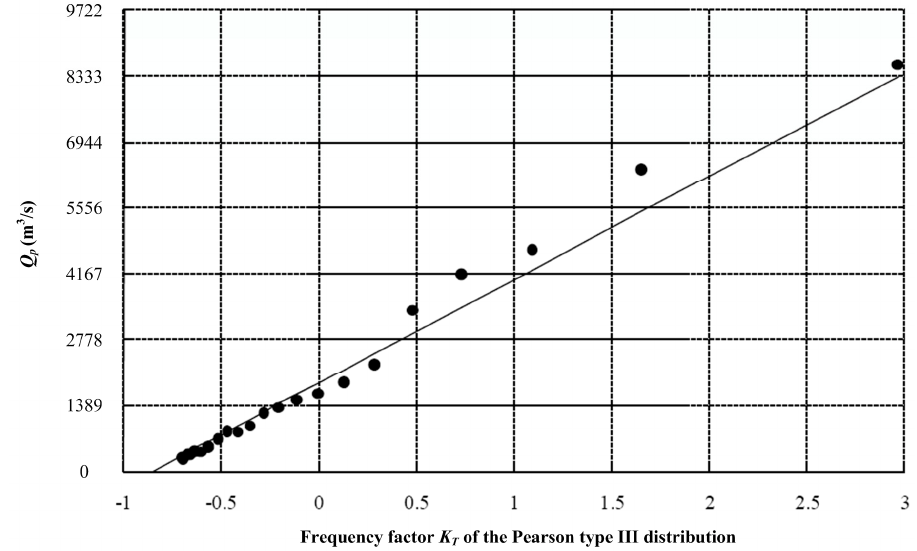
Figure 8. Probability plot of peak inflow ( q p ) of Shih-Men Reservoir for the Pearson Type III distribution.